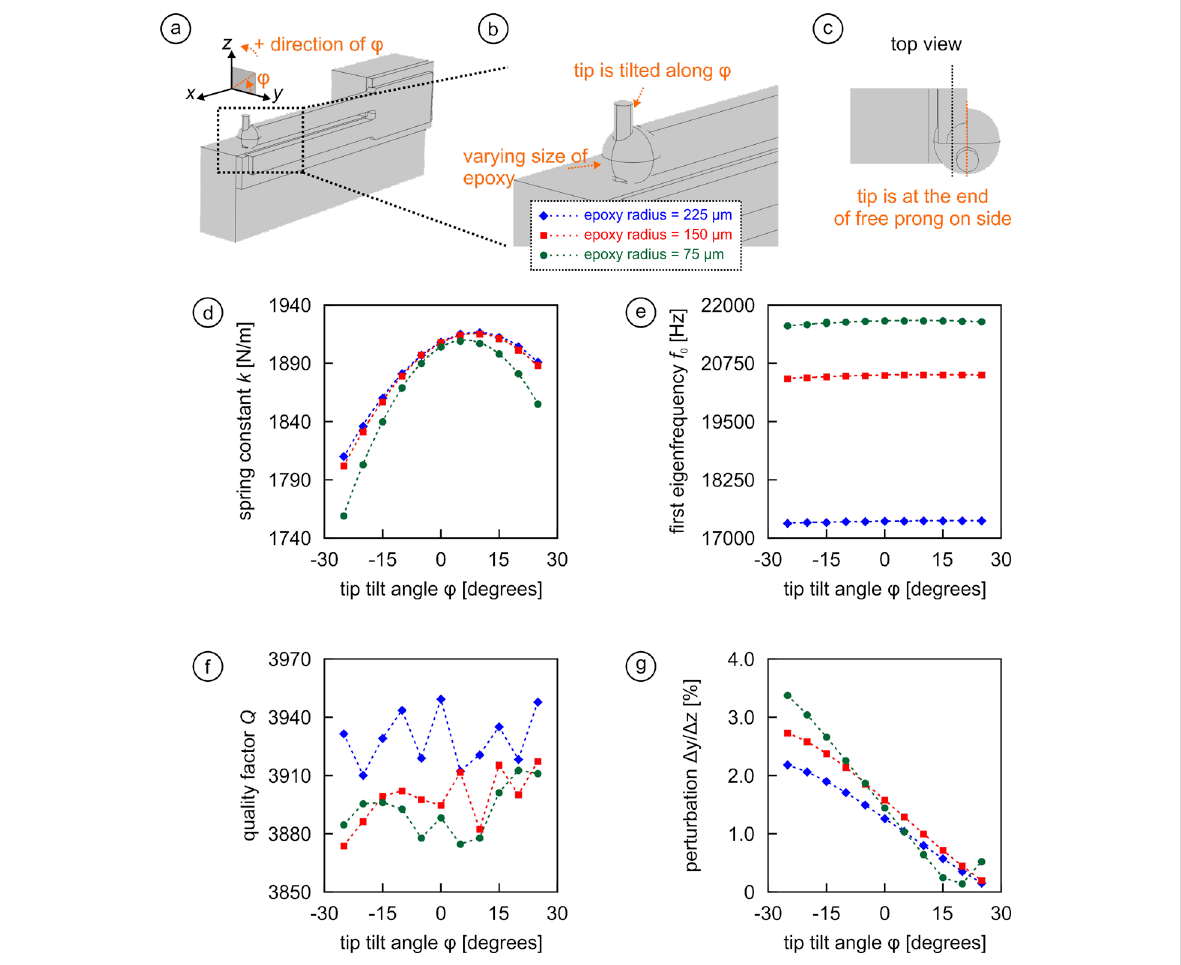
Figure 3: (a–c) Geometrical arrangement and definition of the angle φ for a configuration where the tip is not mounted axially symmetric to the central x – z plane of the free prong, but rather aligned with the far side of the prong when looked at from the holder. (d–g) Effect of the tip tilt angle φ on k , f 0 , Q , and Δ y / Δ z for three different epoxy